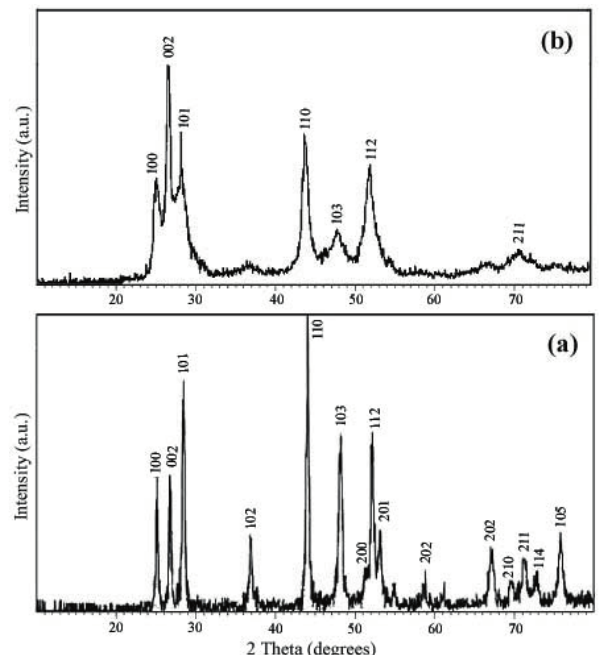
Figure 1. XRD patterns of (a) CdS nanoparticles and (b) CdS